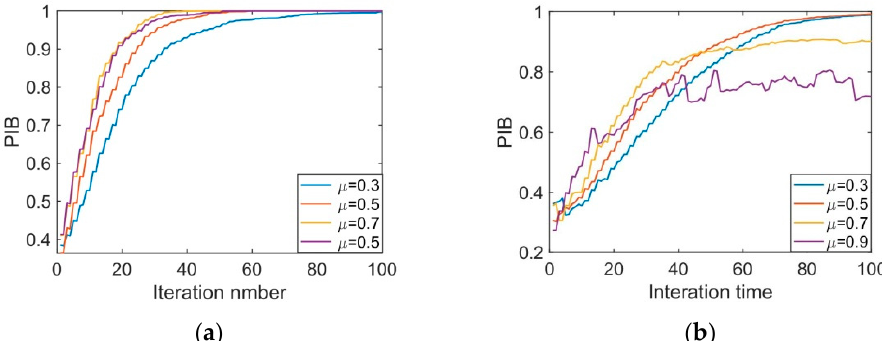
Figure 2. The relationship of system performance index with iteration times under different gain coefficients. ( a ) three-channel; ( b ) seven-channel.